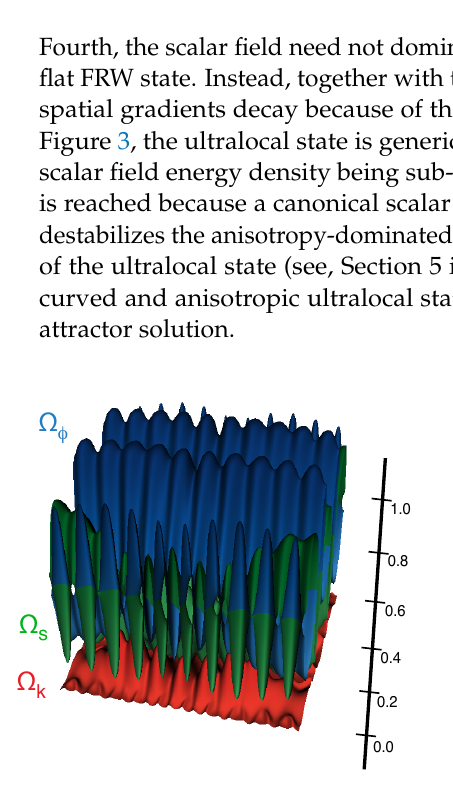
Figure 3. Snapshot of the relative contributions of the three energy density components, Ω φ = scalar field (blue), Ω k = spatial curvature (red) and Ω s = shear (green) at N = 5. As Figure 1 illustrates, the state is ultralocal. Yet, as observed above, in many regions shear (green) dominates and the spatial curvature contribution (red) is